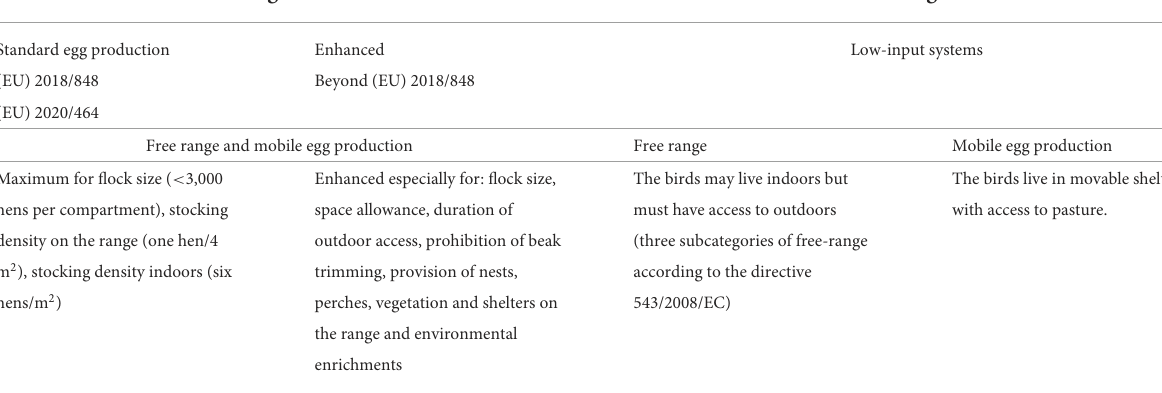
TABLE 1 Characteristics of alternative rearing systems for laying hens *